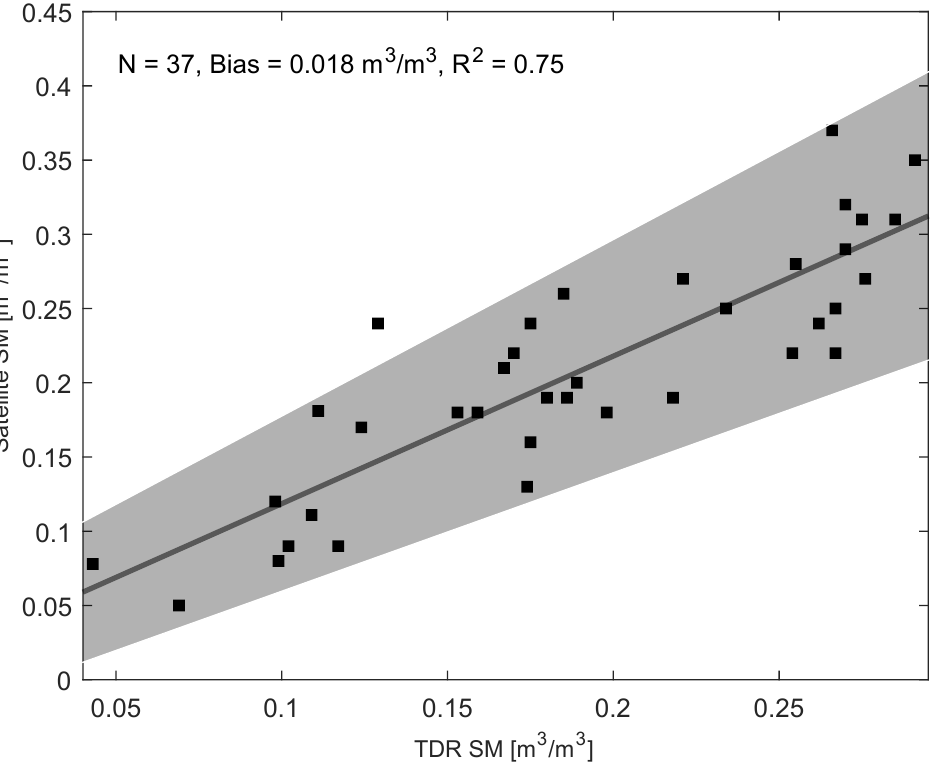
Figure 6. Regression curve between satellite derived and in-situ (TDR) measured soil moisture. Shaded gray region is the 95% confidence level of the regression